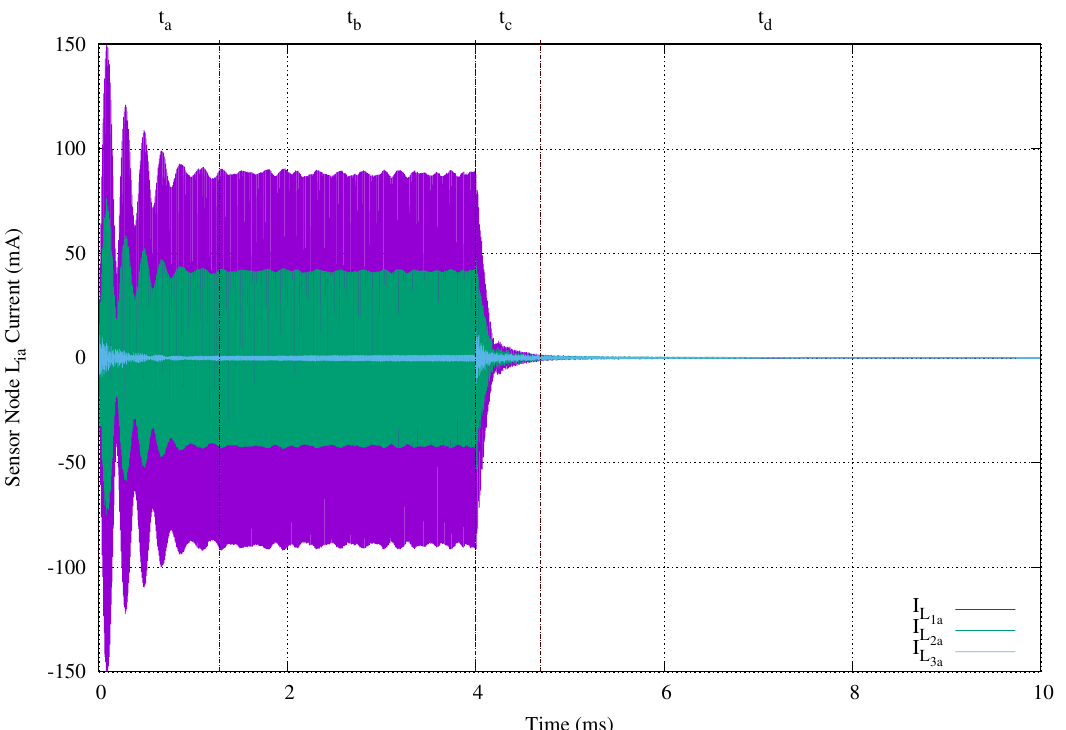
Figure 13. Currents in each transmission antenna of a network branch with five stages when a 4 ms tone of 134.2 kHz is applied and there is a cable breakage at C 4 a